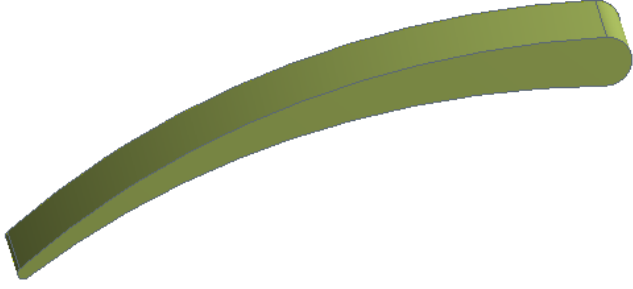
Figure 6. 3D model of turbine stator.